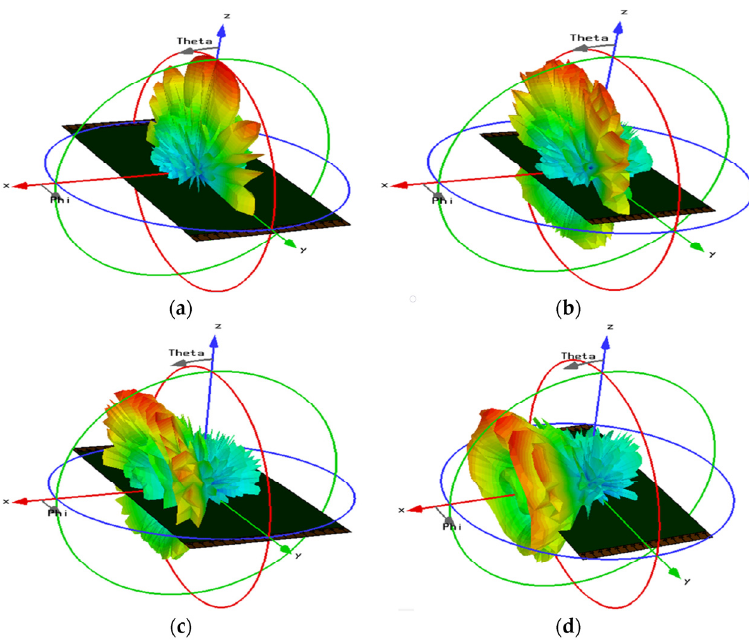
Figure 10. The 3D radiation beams in 28 GHz band at di ff erent scanning angles; ( a ) 0 ◦ , ( b ) 15 ◦ , ( c ) 30 ◦ and ( d ) 45 ◦